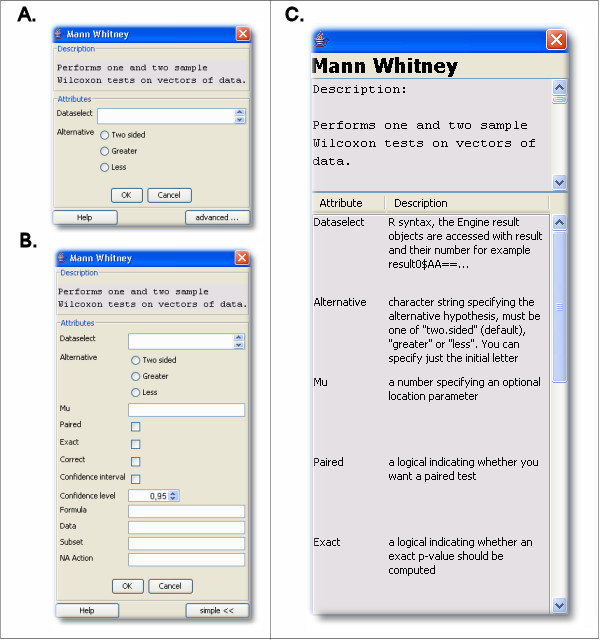
Screenshots of a typical statistical test dialog. A. The Mann-Whitney test dialog in the simple handling mode with reduced parameters. B. The same test in the advanced view with all options allowing full control. C. The built-in help with general description of the test and its parameters. The statistical background information was derived from the R documentation.